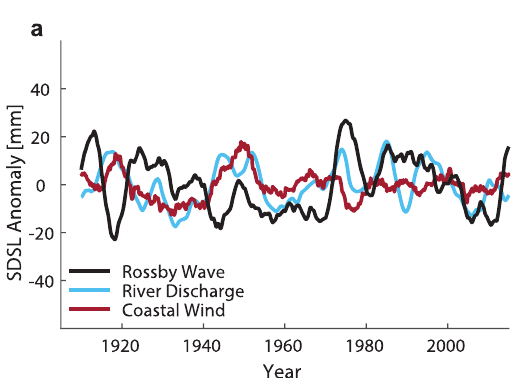
Fig.6|Unforcedresidualsterodynamic(SDSL)changesversusinternalclimate variability along the U.S. Southeast and Gulf coasts. a Individual processes that contribute to coastal SDSL variability averaged (with a median) over all stations south of Cape Hatteras. b Residual SDSL index averaged (with a median) over all stations south of Cape Hatteras after removal of forced variability from Climate ModelIntercomparison Projection (CMIP)5(dashed line) and 6 (solidline) models (i.e., unforced SDSL).The shading indicates the inter-station variability for stations